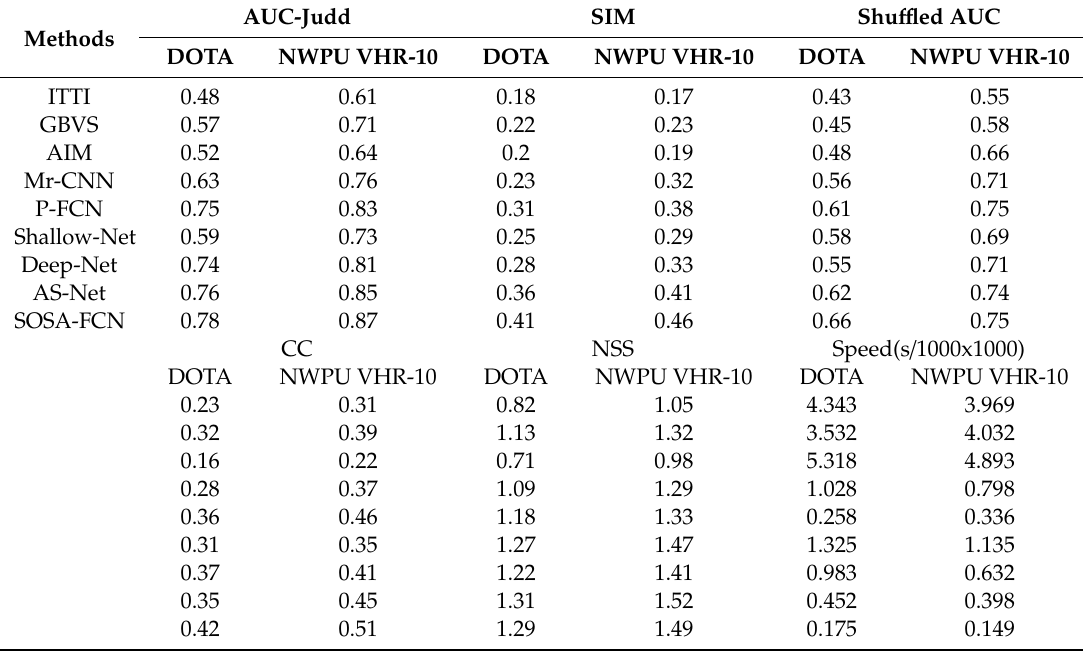
Table 1. Quantitative comparison of di ff erent fixation prediction (FP) models using di ff erent datasets.